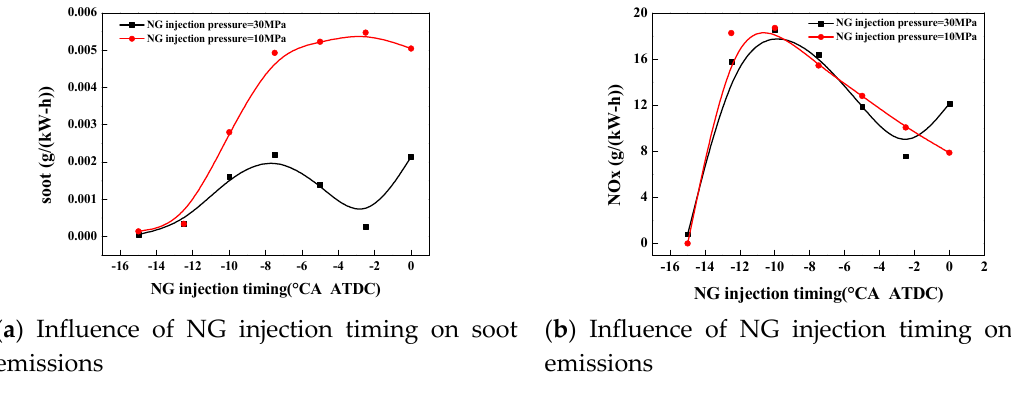
Figure 12. Influence of NG injection timing on soot and NO x emissions.